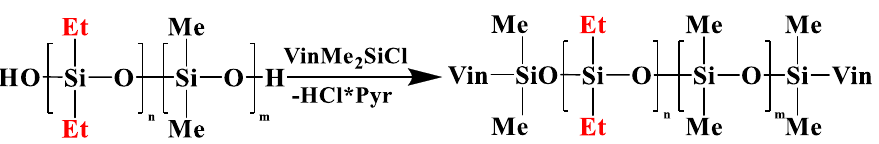
Figure 4. Scheme of blocking linear poly(diethyl)(dimethyl)siloxane ( № 10, Table 2).